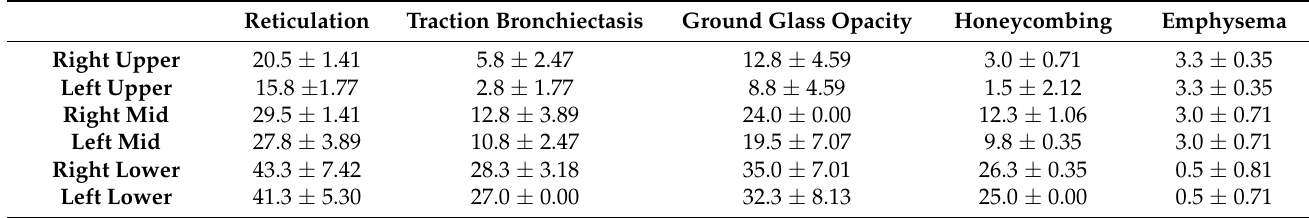
Table 3. HRCT radiographic findings (Score) by lung